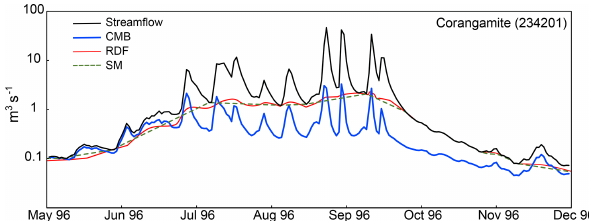
Figure 6. Baseflow fluxes estimated from the CMB and calibrated RDF and SM methods for a 6-month period from gauging sta- tion 234201 in the Corangamite